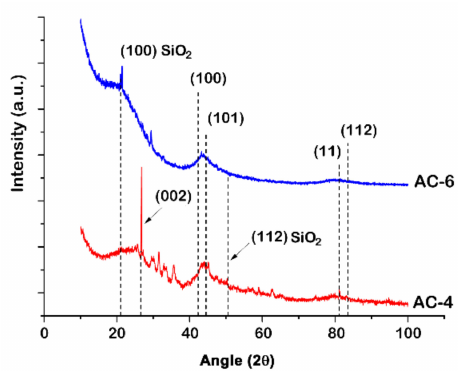
Figure 2. X-ray di ff raction (XRD) patterns for the peat-derived activated carbons: AC-4 and AC-6. Dashed lines show the primary reflections of graphite and quartz.